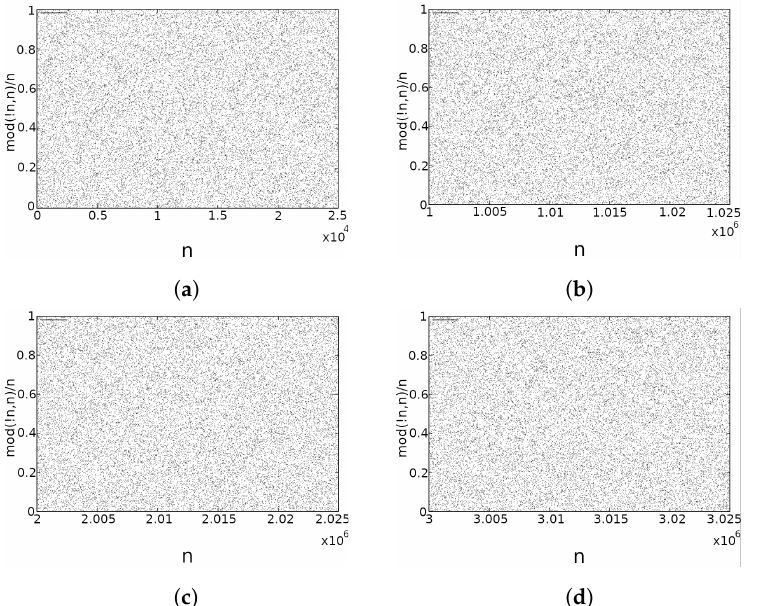
Figure 1. Distribution of mod ( K ( n ) , n ) / n ; ( a ) n in range [ 0 ÷ 2.5 ] × 10 4 , ( b ) n in range [ 1.0 ÷ 1.025 ] × 10 6 , ( c ) n in range [ 2.0 ÷ 2.025 ] × 10 6 , and ( d ) n in range [ 3.0 ÷ 3.025 ] × 10 6 .